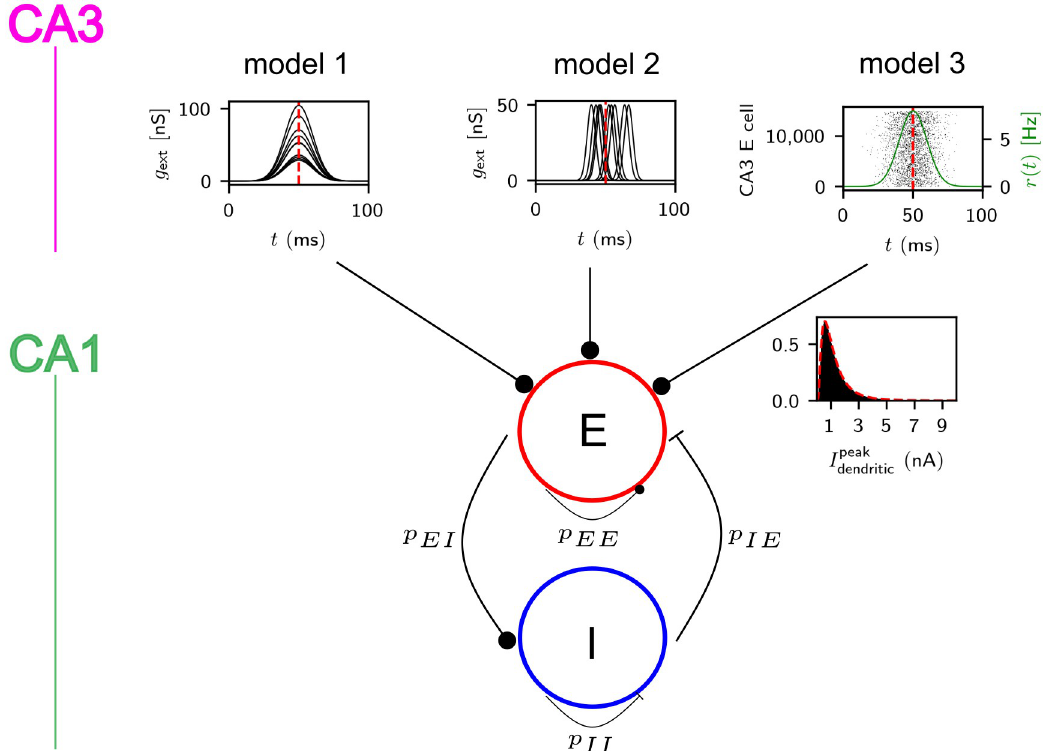
Fig 1. Model overview. The models consist of a population of N excitatory and a population of N inhibitory CA1 neurons, which E I are connected with probabilities p αβ , α , β 2 { E , I } (lower panel) and receive different external input from CA3 (upper panel): In model 1 and 2, it is represented by the excitatory conductances g ext (Eq 6) that it evokes in n CA1 neurons. In model 1, the time E courses of these conductances are broad and for each neuron centered around the same time (upper left panel). In model 2, the time courses are short, pulse-like and centered around different times (upper middle panel). In model 3, CA3 is represented by a population of input neurons. Each such neuron fires according to an inhomogeneous Poisson process with Gaussian rate profile (upper right panel, rate time course (Eq 7, green) is overlaid on spike rastergram). Spike transmission from CA3 to CA1 is then filtered by a strong apical or basal dendrite of the receiving CA1 neuron: Besides the linear input transmission, sufficiently coincident input evokes dendritic spikes. These generate somatic currents whose peak strengths follow a lognormal distribution (the inset shows such a distribution together with its density given by Eq 2 (red dashed)) across neurons.